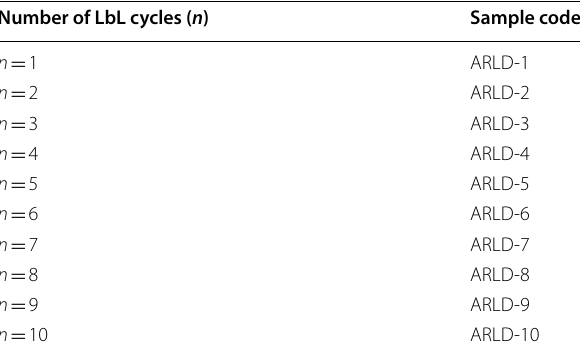
Table 2 The characteristics of prepared electrodes Number of LbL cycles ( n